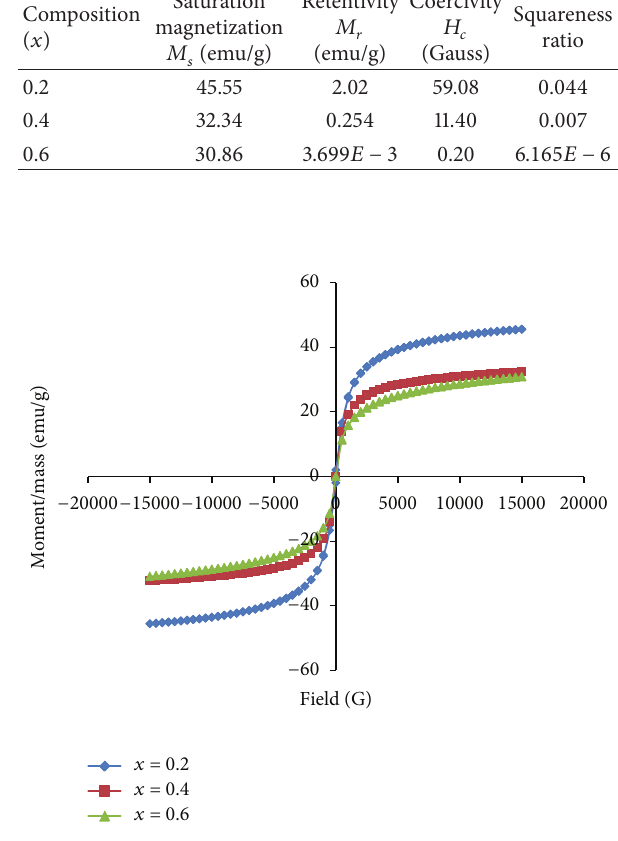
Figure 5: B-H hysteresis loops of